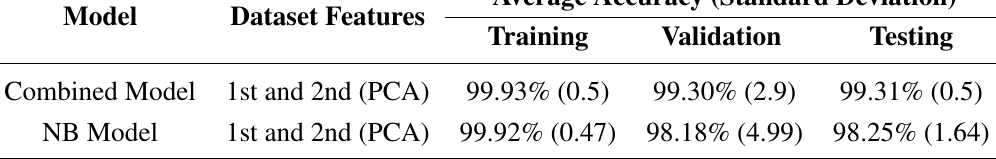
Table 2. First model using Dataset-1 (2-d) performance profile along with a comparison to Naive Bayes model.